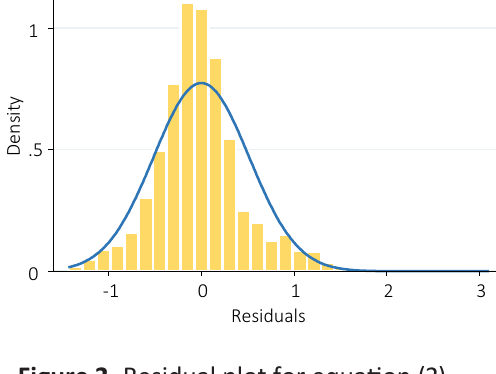
Figure 2. Residual plot for equation (2) Figure 1. Residual plot for equation (1)